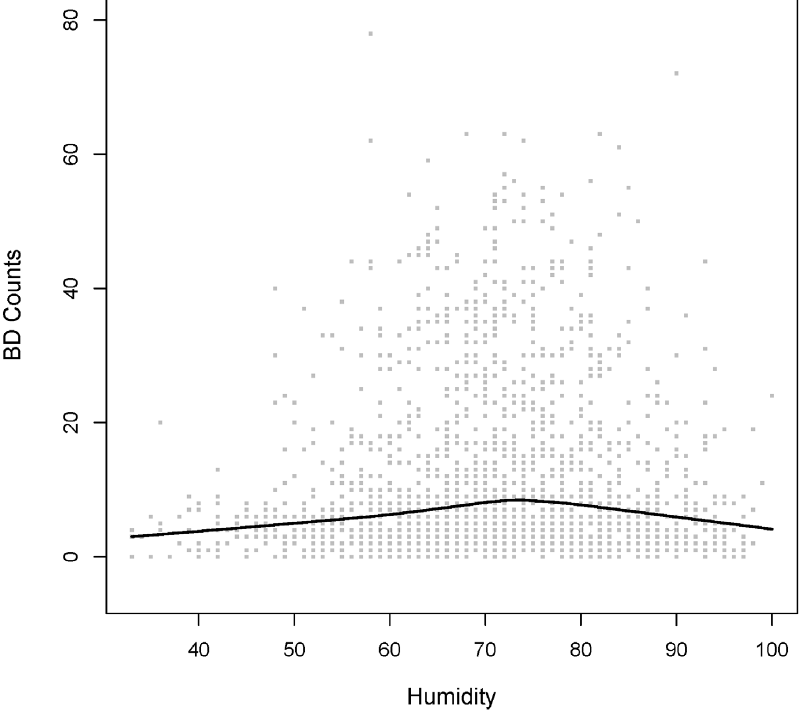
Figure 3. Scatter plot of BD counts vs. Humidity from 2004 to 2008. The solid black line is the Lowess estimator of the association between daily BD counts and daily averaged humidity. doi:10.1371/journal.pone.0062122.g003 PLOS ONE |